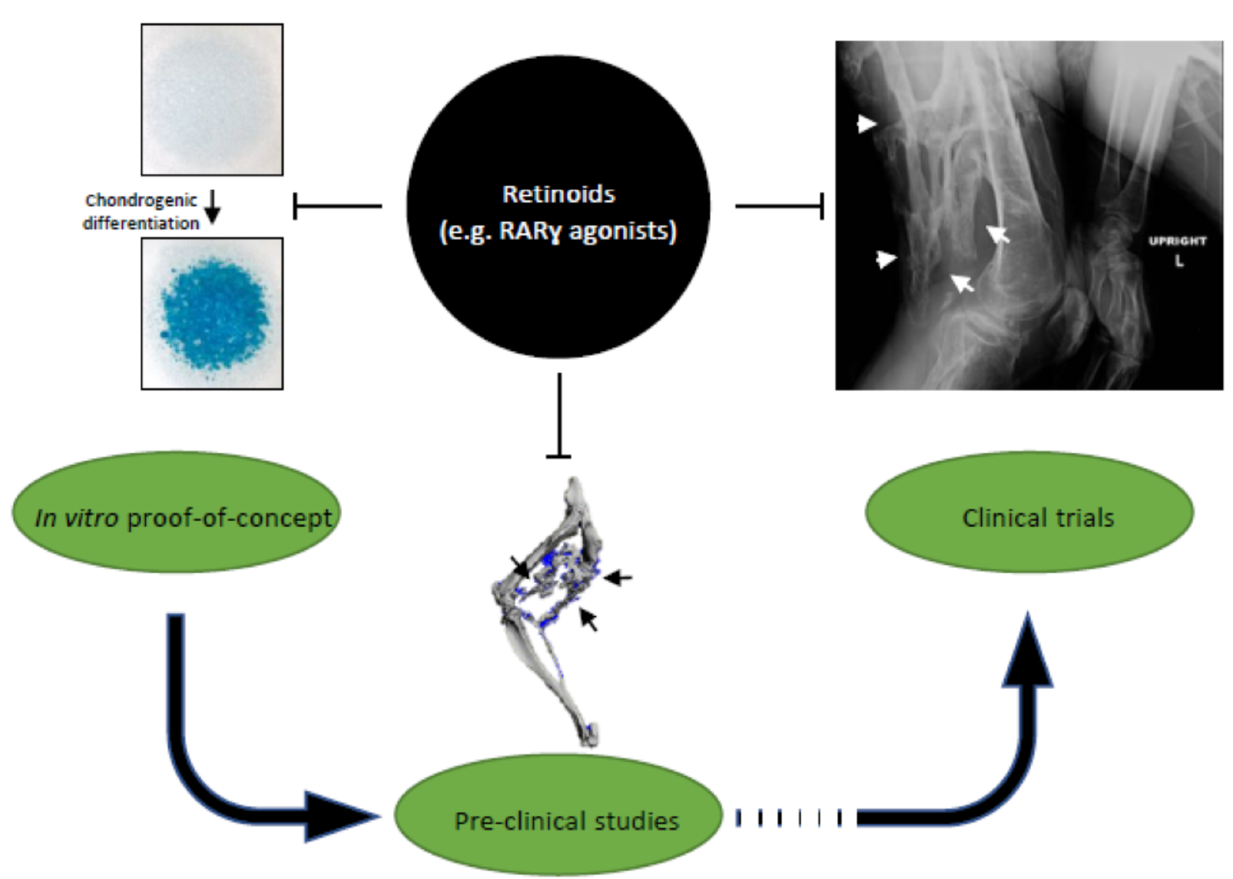
Figure 2. Translation of retinoid signaling roles in chondrogenic differentiation into clinical studies on inhibition of endochondral heterotopic ossification (HO). Retinoids, especially RAR γ agonists, have inhibitory effects on chondrogenesis in micromass cultures (left); preclinical mouse models of HO (middle); and HO formation in fibrodysplasia ossificans progressiva (right).